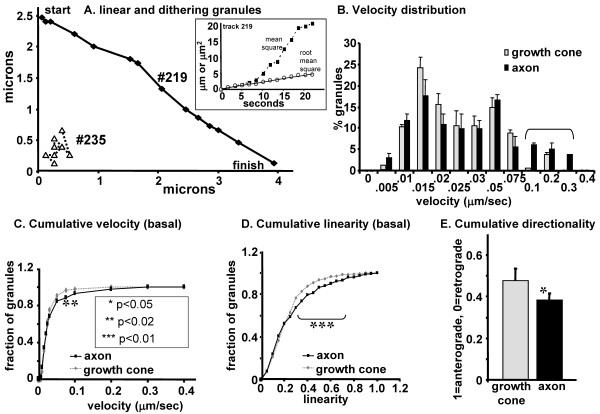
LDCV dynamics in growth cones and axons are fundamentally different under basal conditions. For analysis under basal conditions, neurons were kept in phenol-free L15 medium at or above 30°C. LDCVs containing PHM-GFP were tracked in growth cones and distal portions of axons. Examples of X-Y LDCV trajectories are shown; one showed rapid, directed motion (#219), and the other moved in a slow, dithering manner (#235). Velocity data for identified LDCV trajectories were pooled from 6 cells. The distribution of binned data is shown in the histogram (B), with the cumulative plot (C) emphasizing the differences between the two regions. LDCV trajectories were also analyzed to determine the distribution of linearity (D). Linearity was calculated by comparing how close the actual path was to a straight line representing the distance between the first and last point tracked. Cumulative direction was analyzed based on the mean angle of the trajectory (E) and assigned a score of 1 if anterograde or 0 if retrograde. N = 2760 LDCVs tracked.